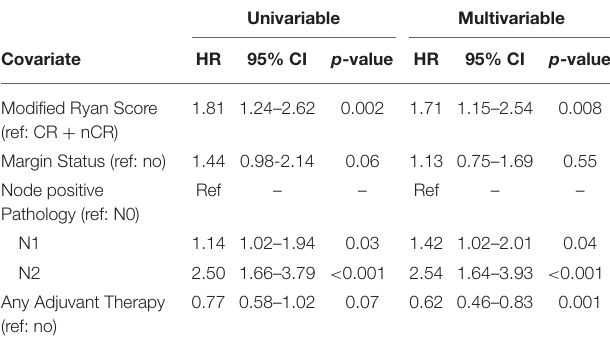
TABLE 2 | Proportional hazards model for overall survival. Univariable Multivariable Covariate HR 95% CI p -value HR 95% CI p